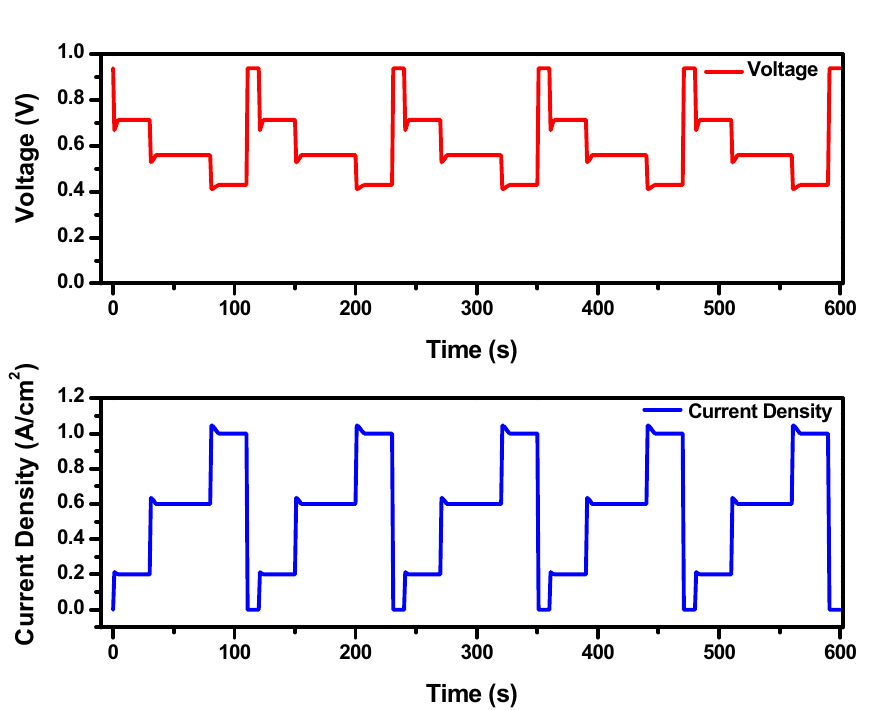
Figure 2. Dynamic load cycle voltage and current